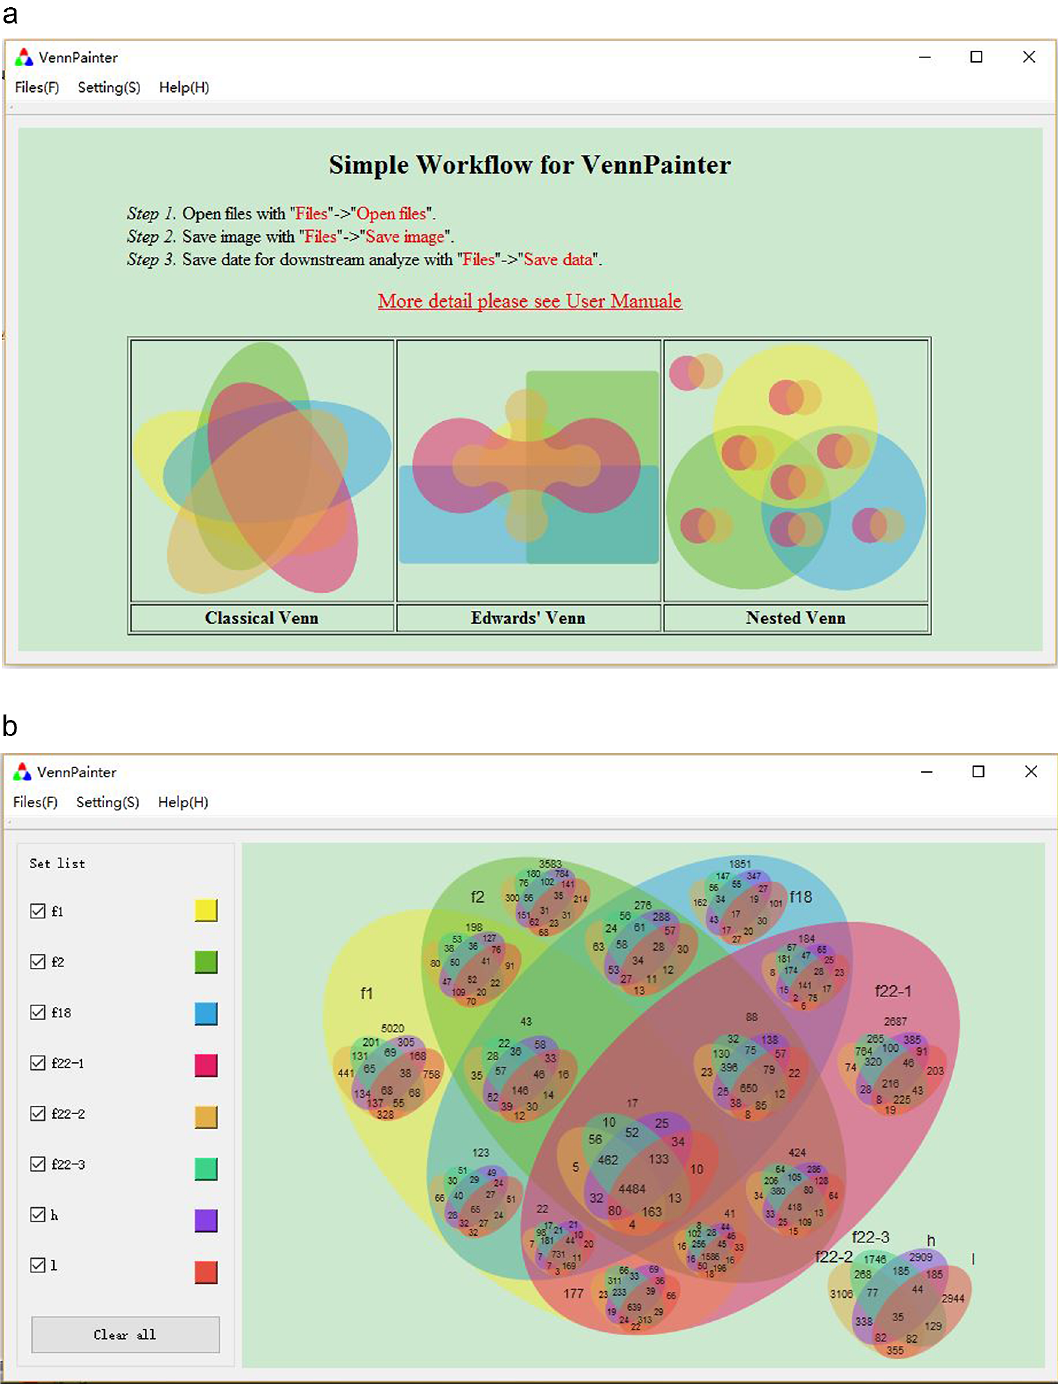
Fig 2. VennPainter GUI. The simple graphical user interface (GUI) for VennPainter. (a) A simple workflow appears on the canvas after loading VennPainter. (b) After loading data, the GUI control panel will appear for customizing colors.